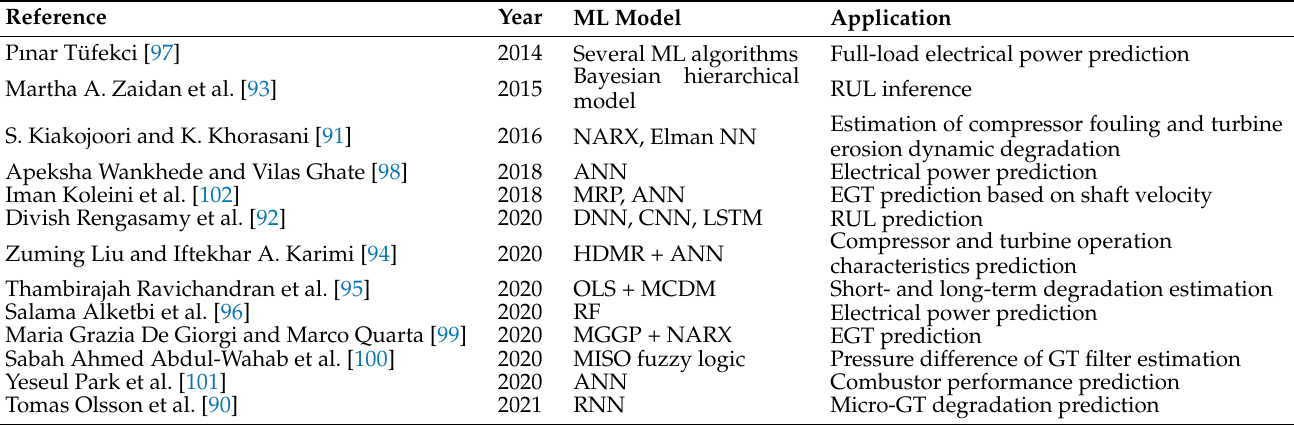
Table 5. Summary of the presented methods for prognostics using machine-learning